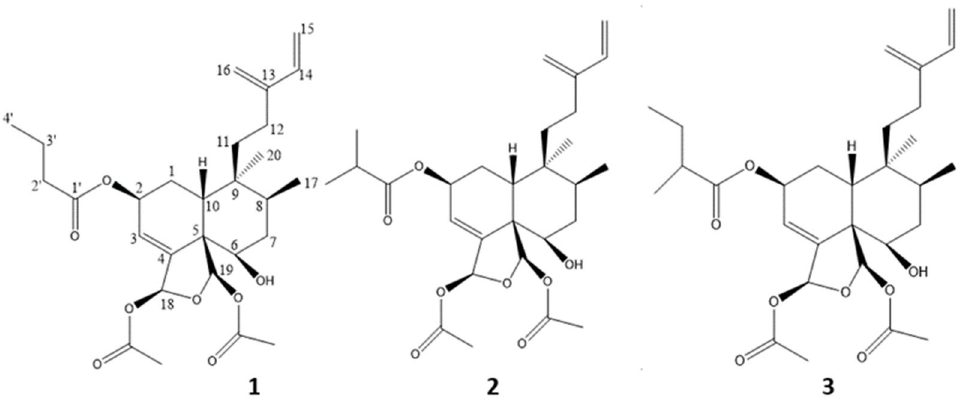
Figure 1. Structures of compounds 1 – 3